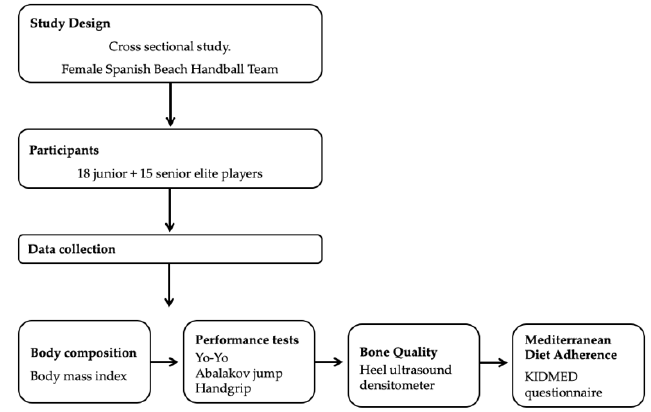
Figure 1. Material and methods scheme.